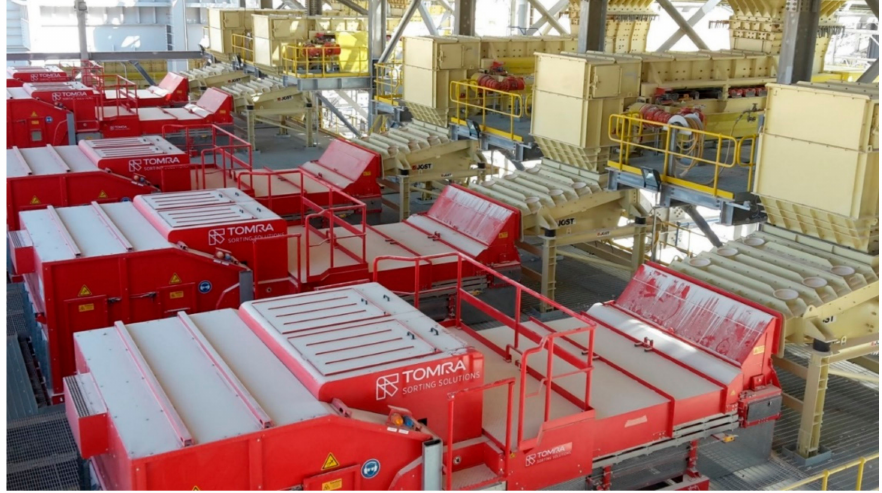
Figure 6. XRT-based sorters at Umm Wu’al phosphate mine, Saudi